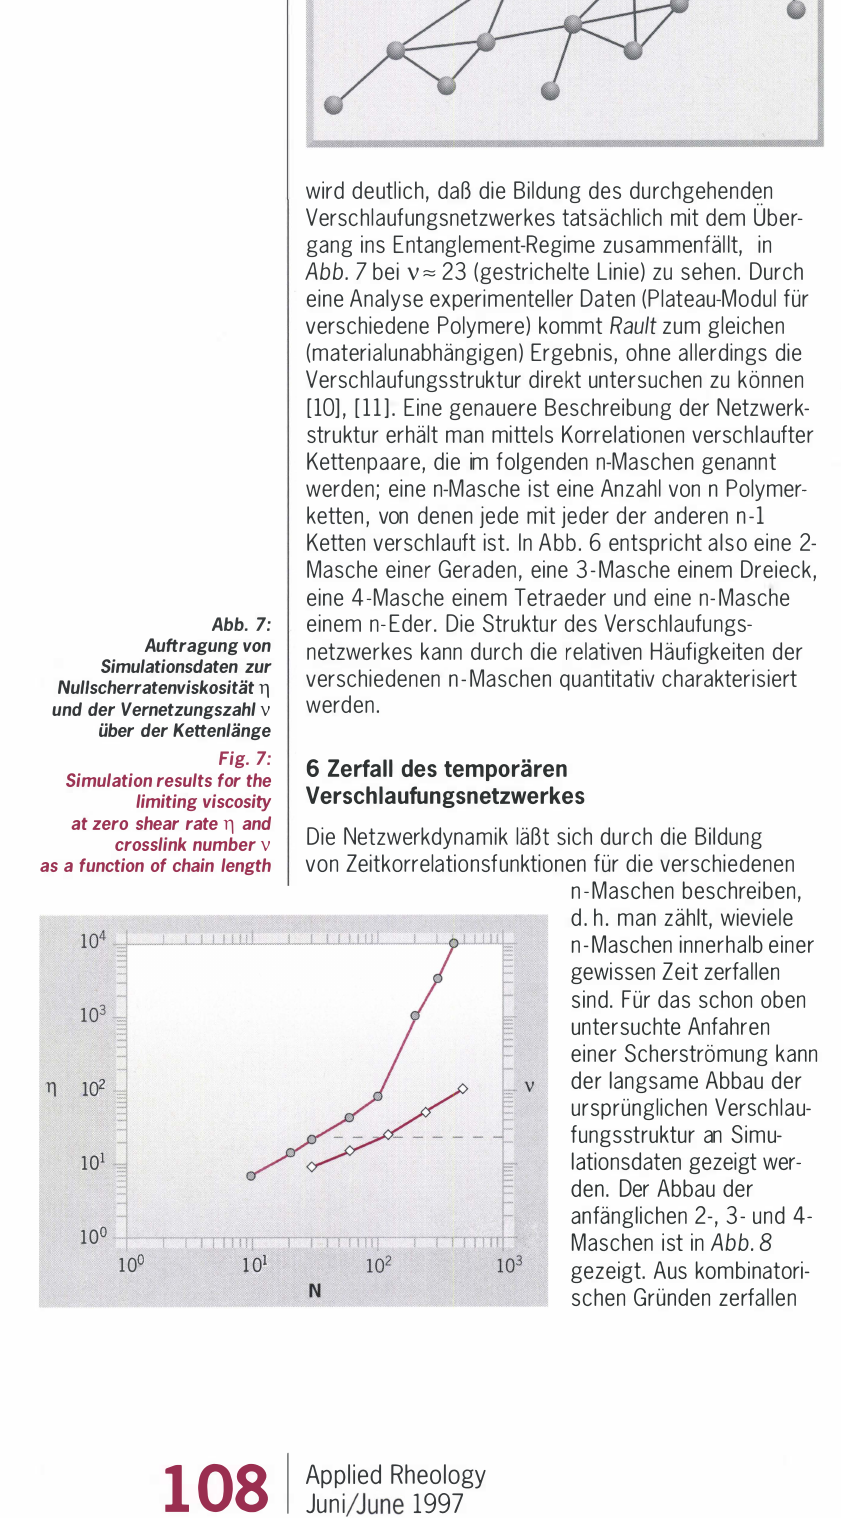
Fig. 6: Cross-section of a temporary entangled network of a polymer melt